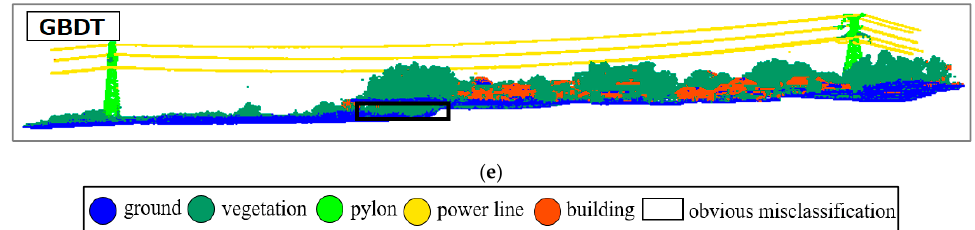
Figure 7. The classification results of site II with different classifiers. ( a ) The point clouds colored by the true labels; ( b ) the point clouds colored by the KNN prediction results; ( c ) the point clouds colored by the LR prediction results; ( d ) the point clouds colored by the RF prediction results; ( e ) the point clouds colored by the GBDT prediction results. The black box is an area of obvious misclassification.